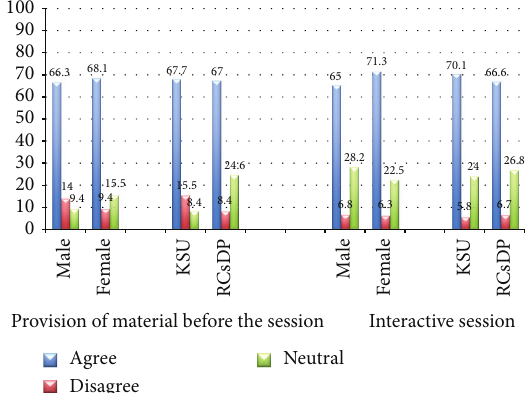
Figure 5: Percentage of dental students’ preferences regarding havingaccesstomaterialsbeforethesessionandinteractivesessions.